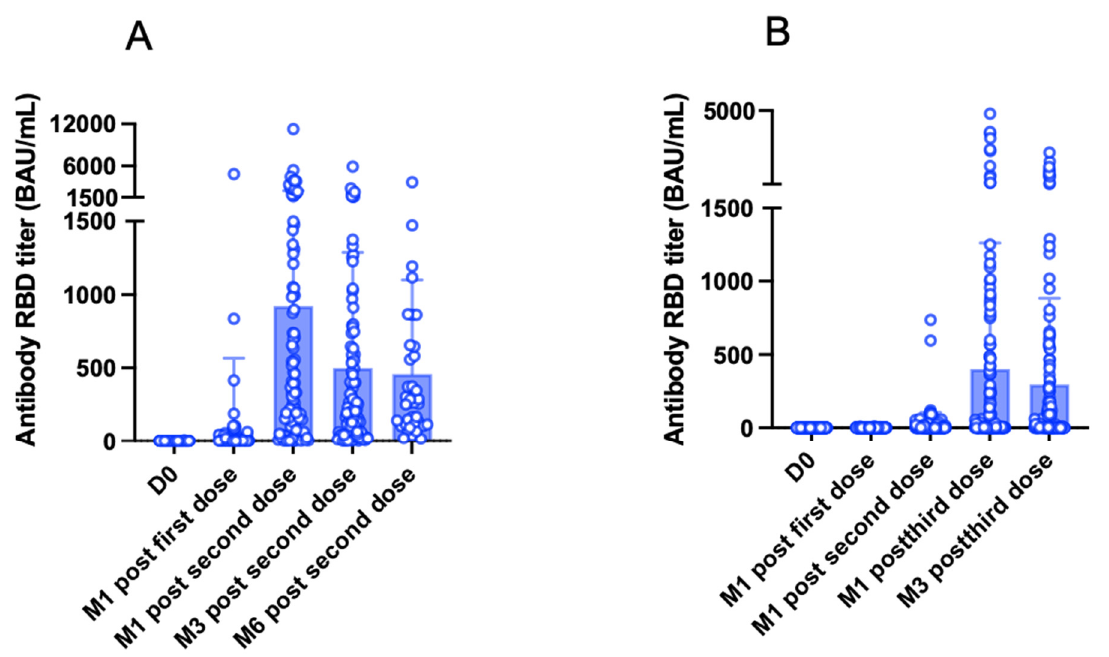
Figure 8. Antibody titers over time. ( A ). Assessments were performed on the vaccination day (D0), one month (M1) after the first dose, one month after the second dose, three months (M3) after the second dose ( n = 100), and six months (M6) after the second dose ( n = 38). White dots represent individual values, whereas blue bars and the black lines indicate the means standard deviations, respectively. In the subgroup of 100 patients, antibody titers decreased significantly from 992.8 ± 1546 BAU/mL at one month to 499.7 ± 788.6 BAU/mL at three months ( p < 0.0001). A further decrease was observed between three and six months in the subgroup of 38 patients (from 754.6 ± 673.3 BAU/mL to 263.1 ± 598.1 BAU/mL, respectively). ( B ). Assessments were performed on the vaccina- tion day (D0), one month (M1) after the first dose, one month (M1) after the second dose, one month (M1) after the third dose, and three months (M3) after the third dose in a subgroup of 136 patients. White dots represent individual values, whereas blue bars and the black lines indicate the means and standard deviations, respectively. Antibody titers decreased significantly from 401.7 ± 860.2 BAU/mL at M1 to 296.1 ± 588 BAU/mL at M3 ( p = 0.01).